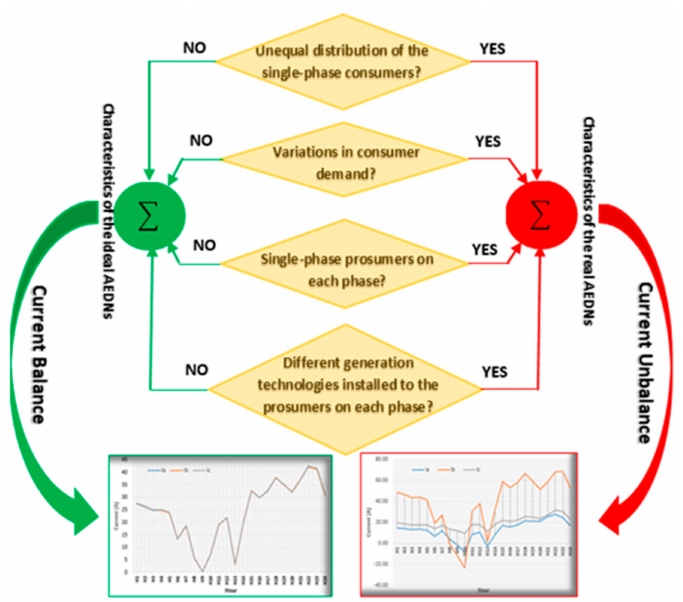
Figure 1. The causes of the current unbalance in the